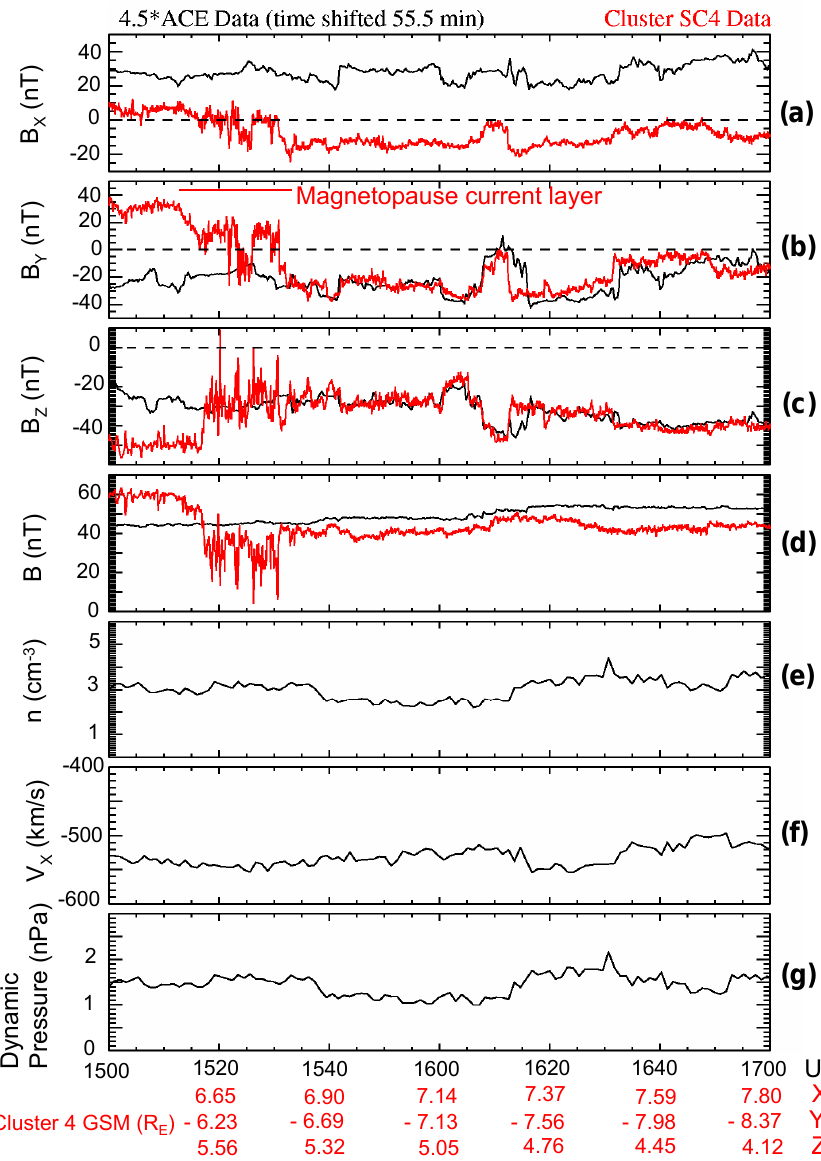
Fig. 2. Interplanetary measurements in GSM coordinates from ACE (black) compared with those from Cluster (red). The ACE magnetic field measurements were multiplied by 4.5 to allow for the jump in magnitude across the bow shock. They were also time shifted by 55.5min to provide the best overall agreement between the Y and Z components during the interval. While the lag time varies some during the two-hour interval, 55.5min gives the best overall lag estimate. In addition to magnitude and three components of B , we also show the solar wind density, velocity, and dynamic pressure as measured at